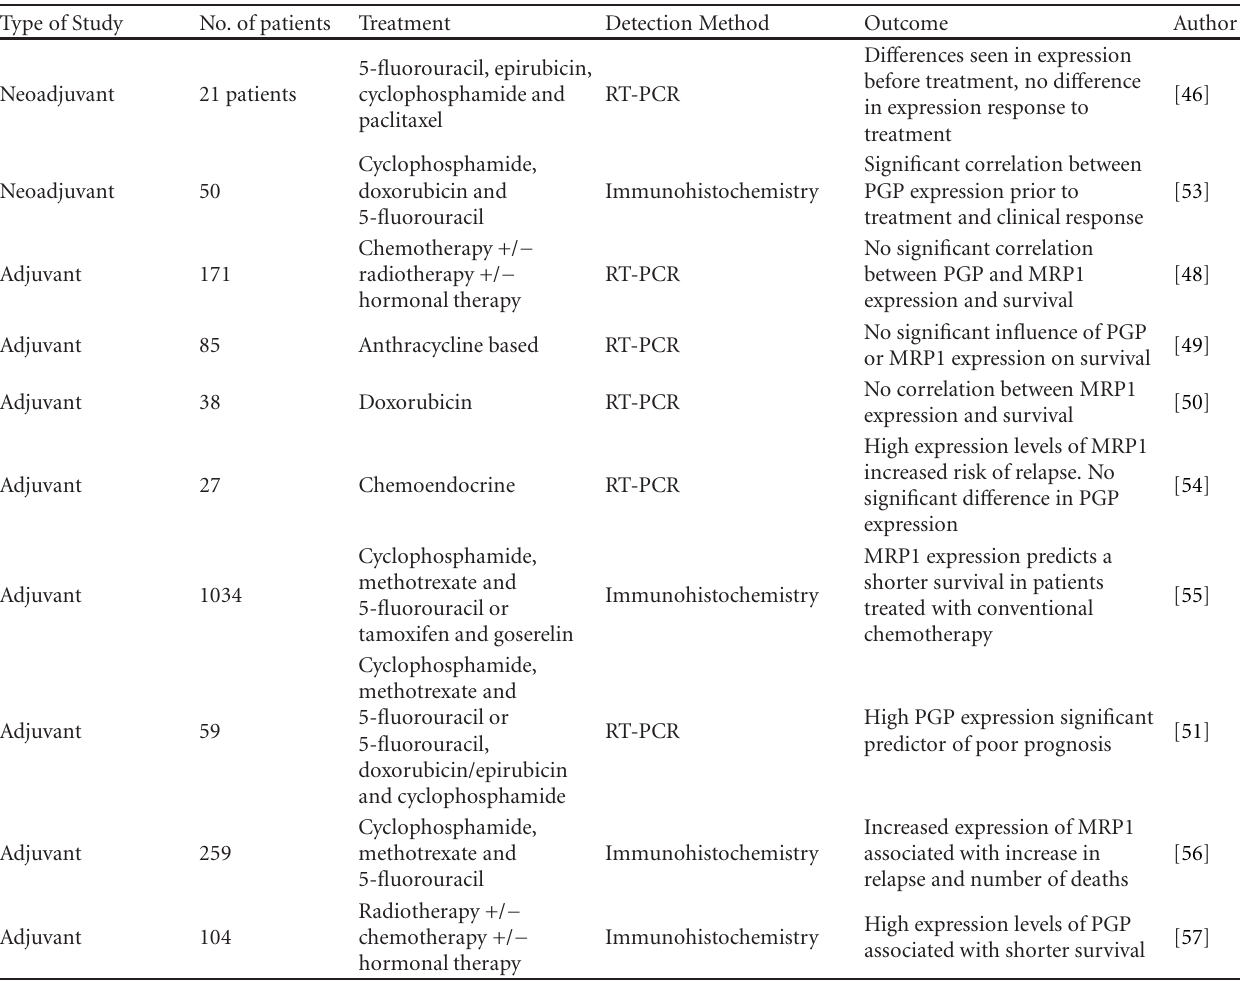
Table 4: Overview of clinical studies investigating the e ff ect of ABC